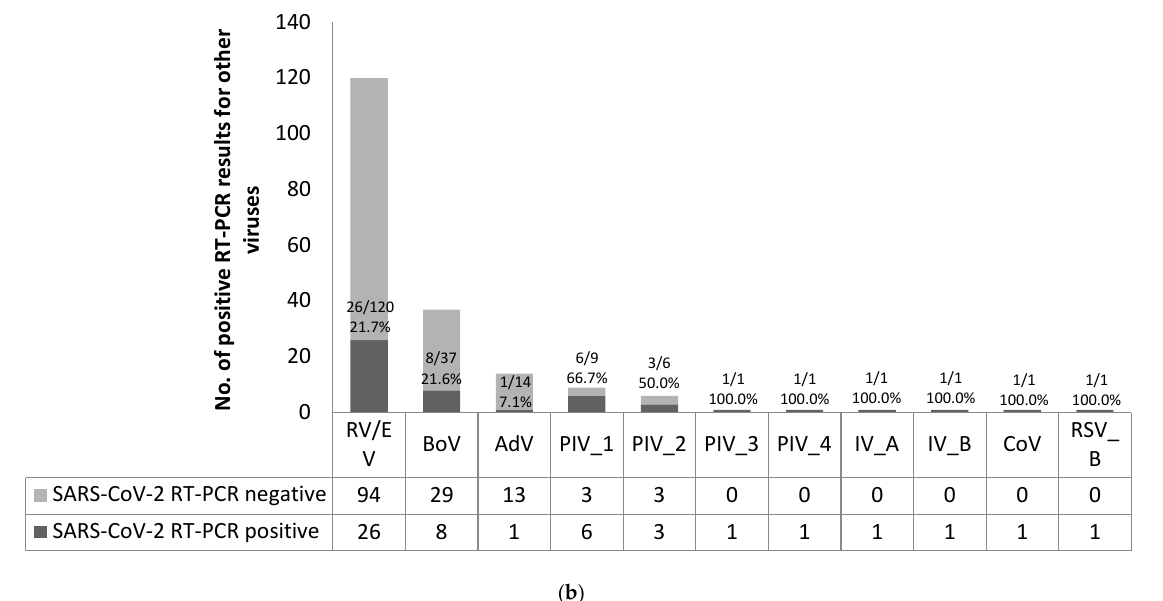
Figure 1. Distribution of other respiratory viruses: ( a ) in first-reported adult cases; ( b ) in children. Abbreviations: SARS-CoV-2, severe acute respiratory syndrome coronavirus 2; RT-PCR, reverse-transcriptase polymerase chain reaction; RV/EV, rhinovirus/enterovirus; BoV, bocavirus; AdV, adenovirus; PIV_1/2/3/4, parainfluenza virus 1/2/3/4; IV A/B, influenza virus type A/B; CoV, coronavirus; RSV_B, respiratory syncytial virus type B.